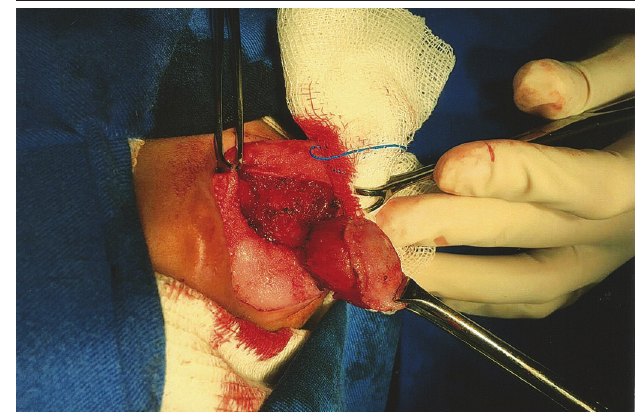
Figura 2 − Remoção cirúrgica da lesão